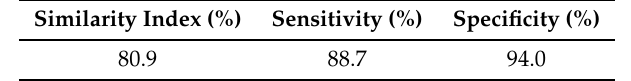
Table 4. Average measures obtained on the dataset: “Brain Tumor in MRI” [65].